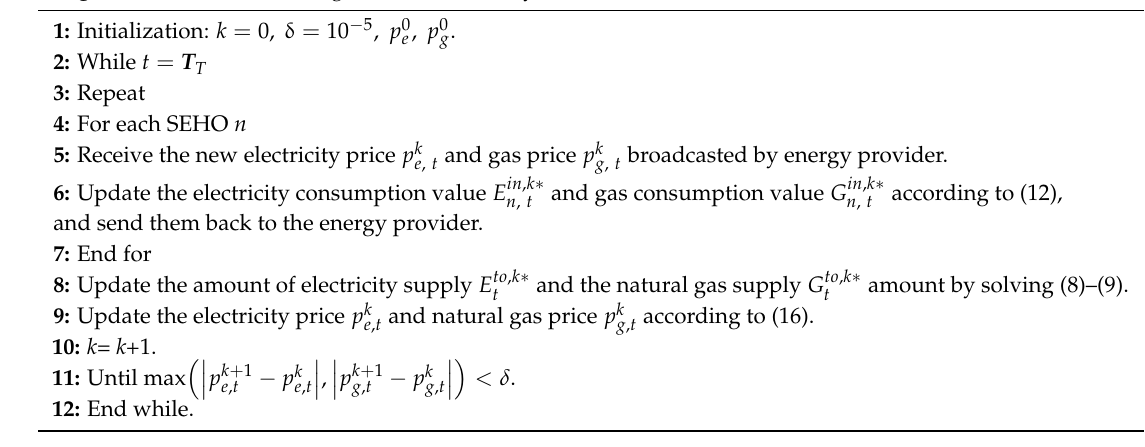
Algorithm 1: An iterative algorithm executed by the EP and